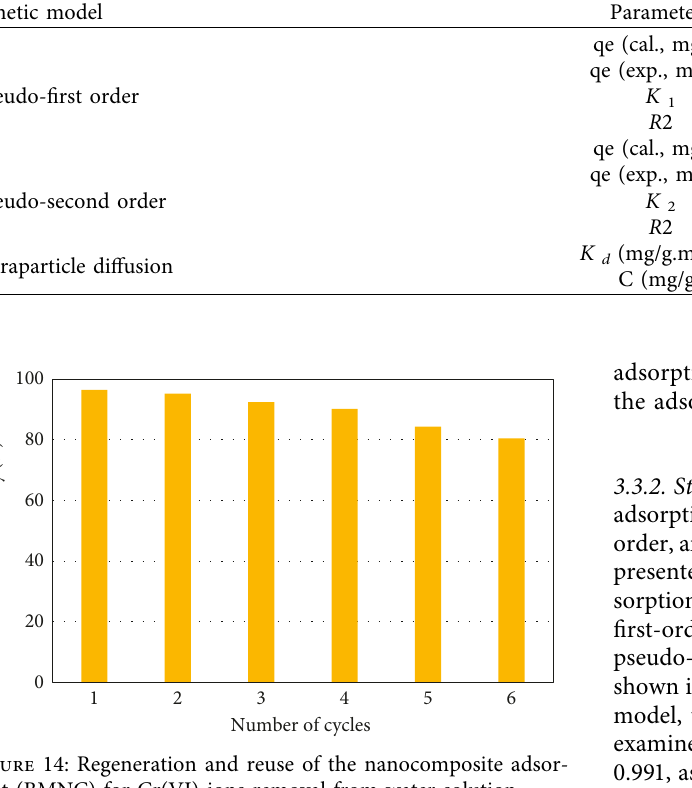
Table 9: Parameters of kinetic models for Cr(VI) ion adsorption onto the nanocomposite adsorbent (BMNC). Kinetic model